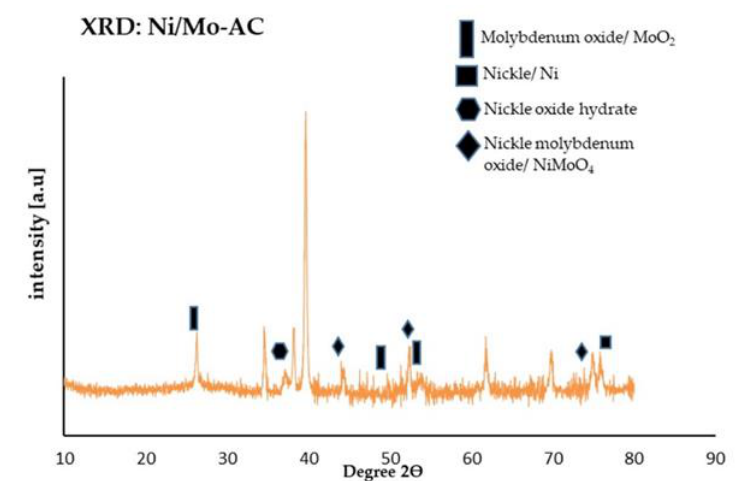
Figure 3. XRD diffraction of the calcined NiO-MoO/AC catalyst. Processes 2020 , 8 , x FOR PEER REVIEW